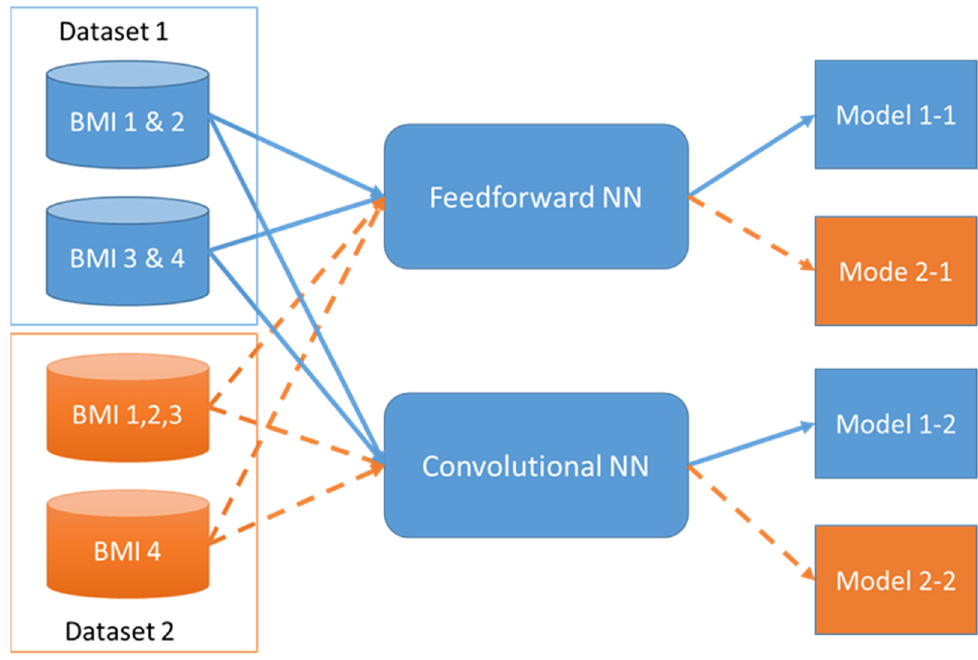
Figure 3. Training the feedforward and the convolutional neural network models.